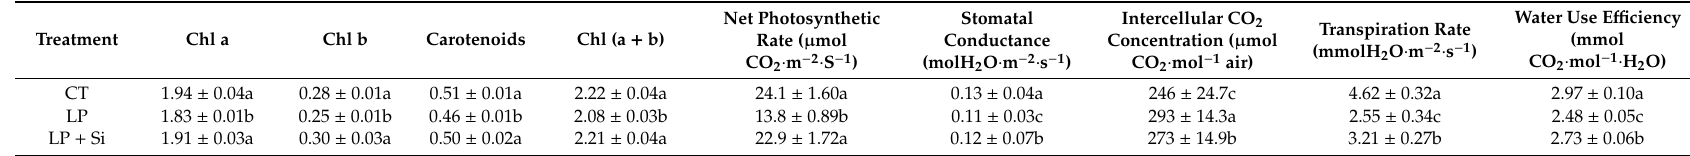
Table 2. E ff ect of exogenous silicon on chlorophyll content and gas exchange parameters in tomato leaves under deficit phosphorus